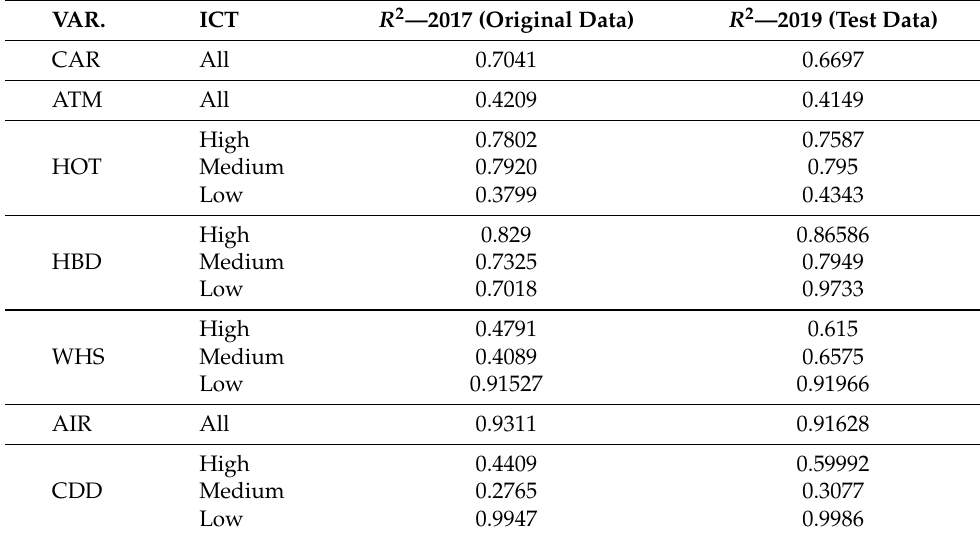
Table A2. Model fit